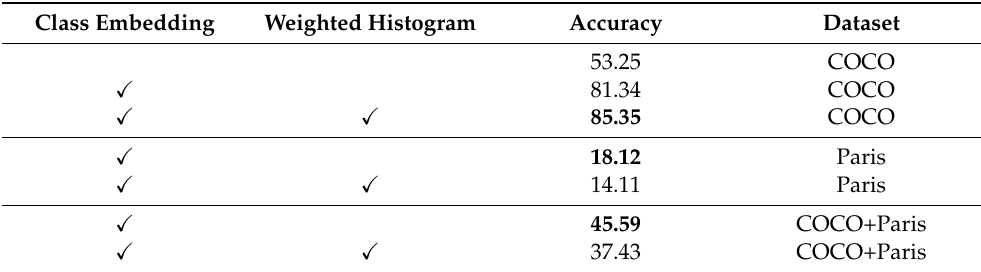
Table 3. The ablation study of class embedding and weighted histogram. The bold means the best accuracy for each dataset.